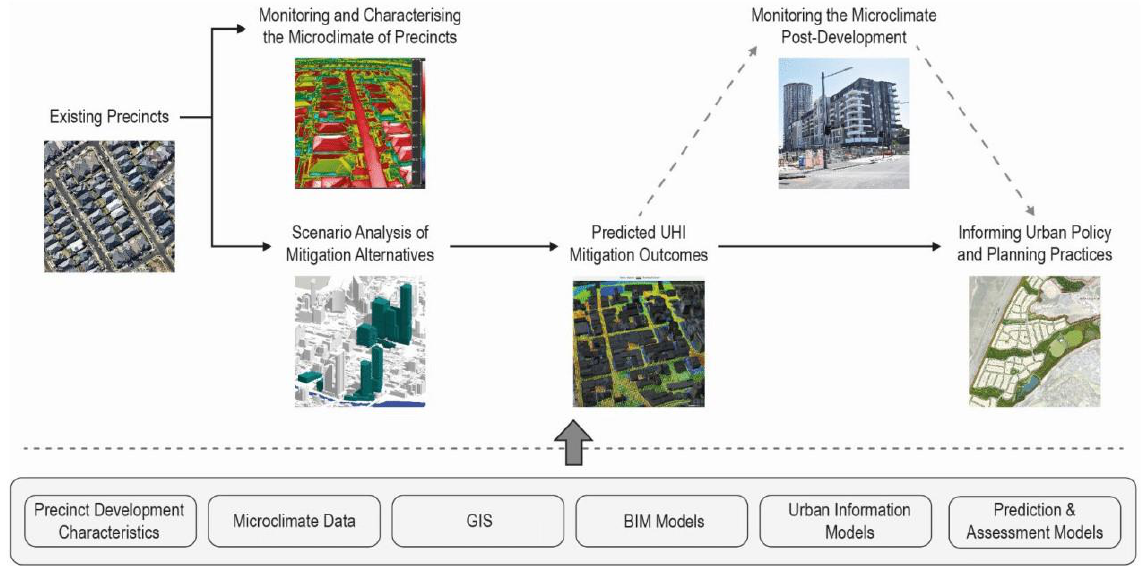
Figure 3. Framework of RP2023; Microclimate and Urban Heat Island Mitigation Decision-Support Tool [29].